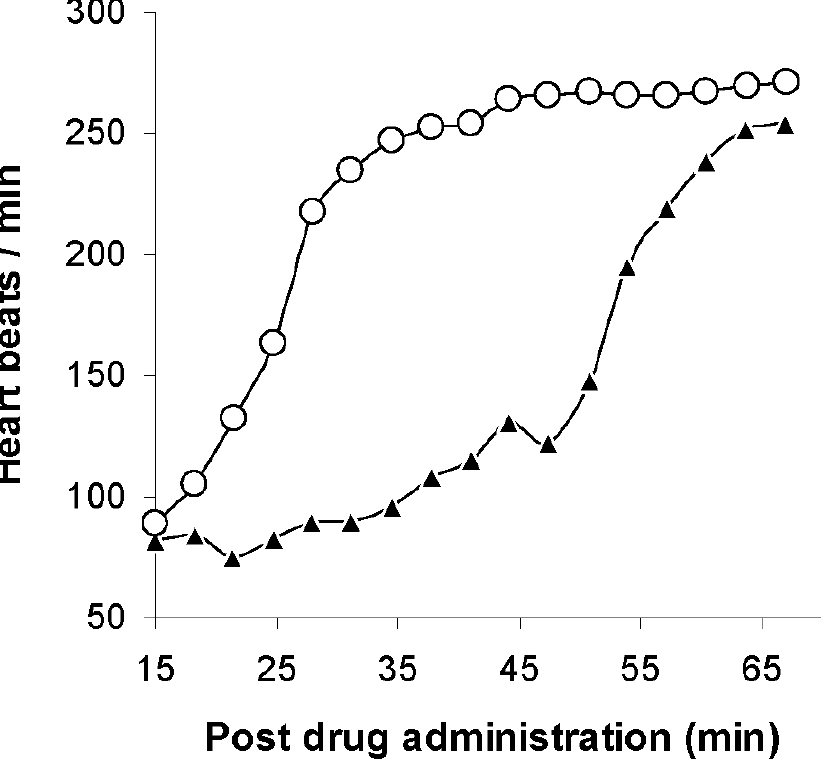
Figure 3. Heart rate recovery in rats treated 15 min after amitriptyline administration with spherulites (O) and no spherulites ( ▲ ), adapted from Dhanikula et al. with permission